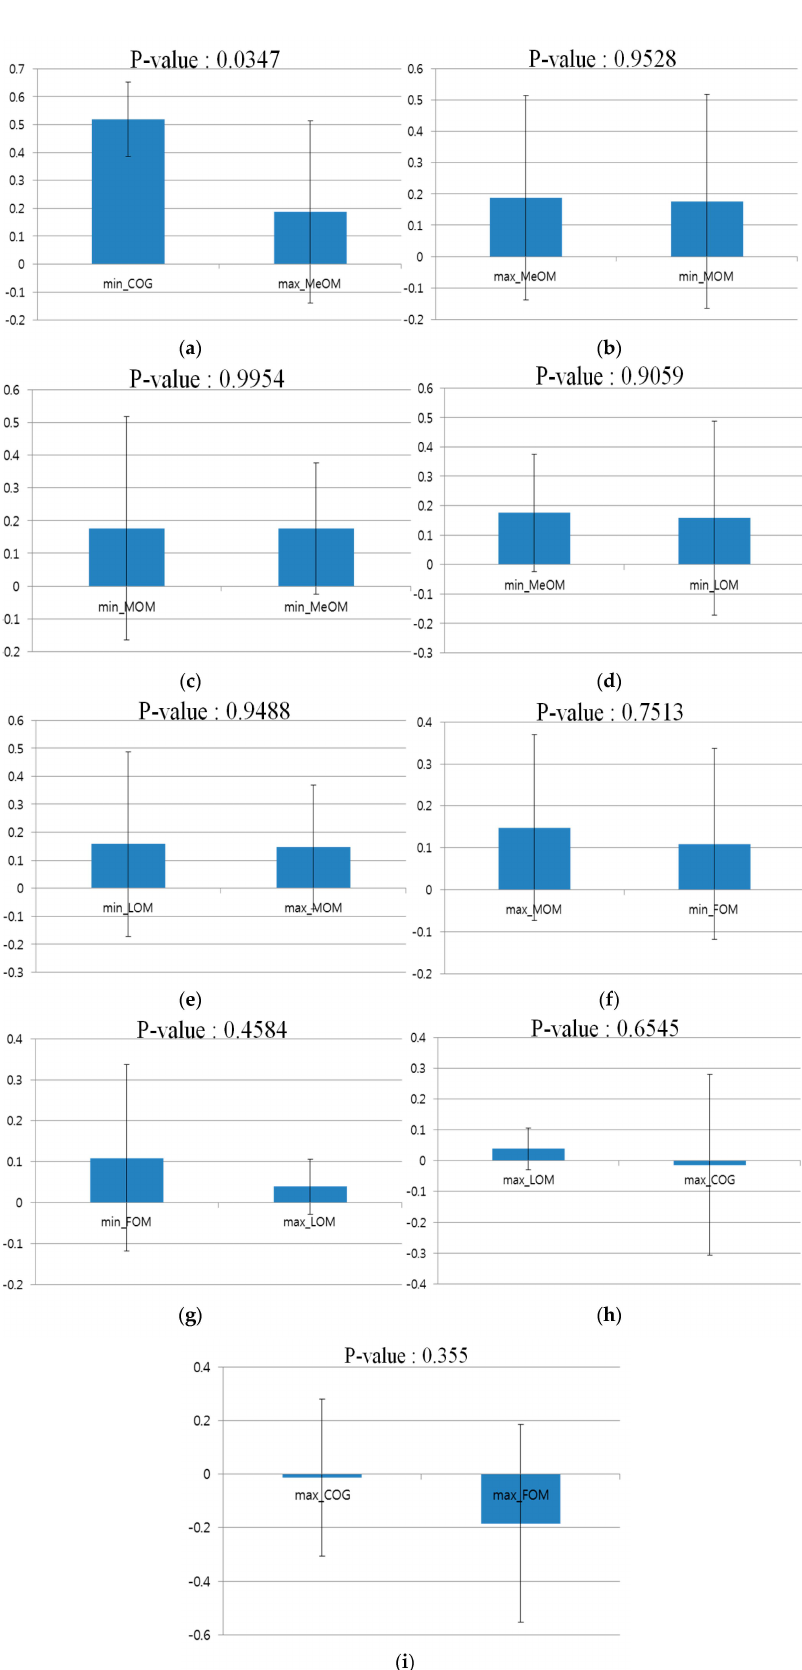
Figure 20. A t -test between defuzzification methods based on the correlation value ranking of Figure 19: t -test between ranks ( a ) 1 and 2, ( b ) 2 and 3; ( c ) 3 and 4; ( d ) 4 and 5; ( e ) 5 and 6; ( f ) 6 and 7; ( g ) 7 and 8; ( h ) 8 and 9; and ( i ) 9 and